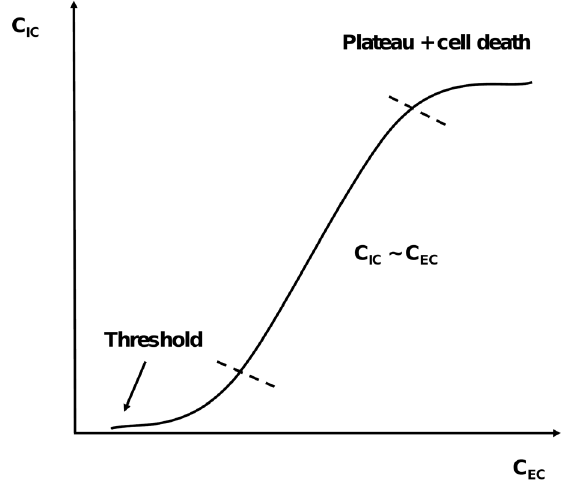
Figure 3. Supposed dependence of the intracellular CPP concentration on the extracellular concentration when per- forming cellular influx studies.